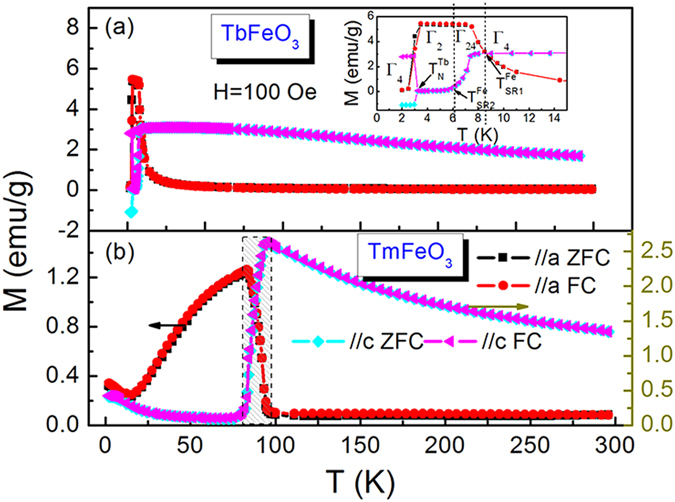
Zero-field-cooled (ZFC) and field-cooled (FC) thermal magnetization curves.(a) of TbFeO3 along a and c axis; and (b) of TmFeO3 along a and c axis from 2 K to 300 K under a magnetic field of 100 Oe. Insets: thermal magnetization curves along a and c axis of TbFeO3.